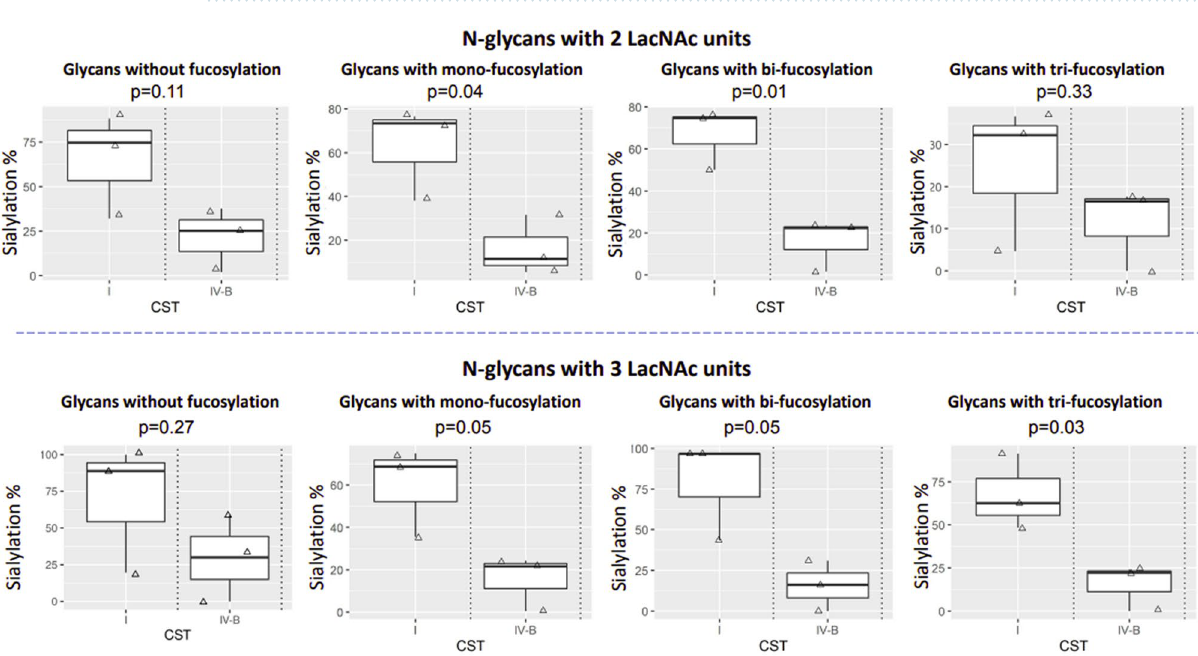
Figure 7. CVF samples with CST IV-B had lower levels of sialylation than those with CST I, regardless of fucosylation. N-glycans with 2 LacNAc units (top panel) and 3 LacNAc units (bottom panel) were selected for analysis. The glycans were grouped based on the number of Fuc they have. In each group, the relative intensity of sialylated glycans to total glycan itensity was calculated as sialylation